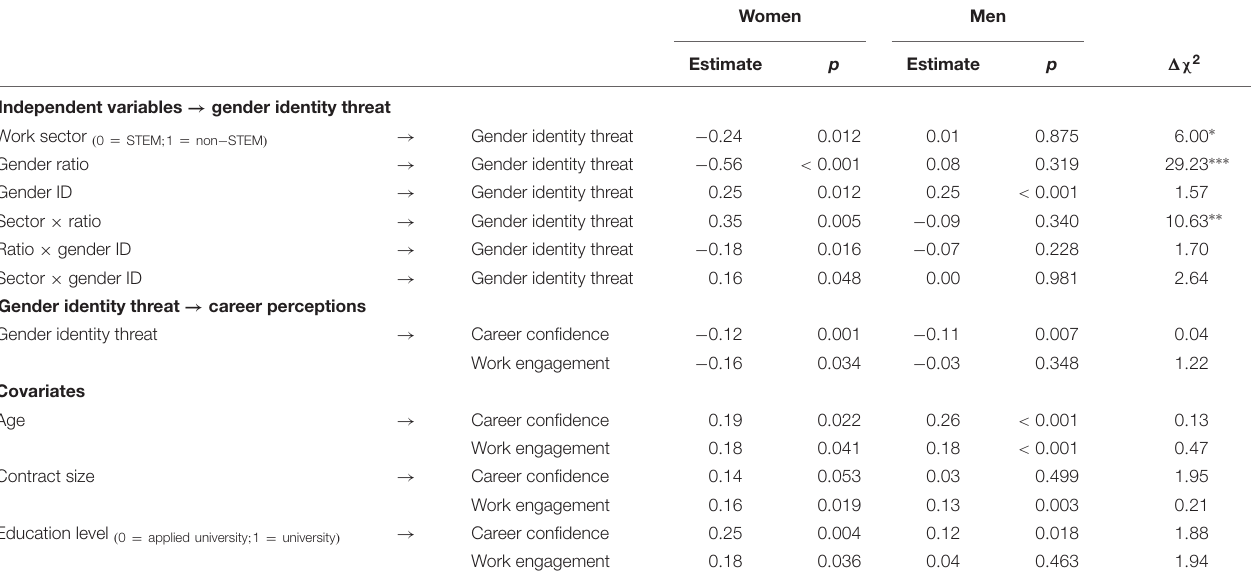
TABLE 3 | Standardized direct and indirect effects parameter estimates and path-by-path analysis on (cid:49) χ 2 for both gender groups (women N = 177; men N = 630)